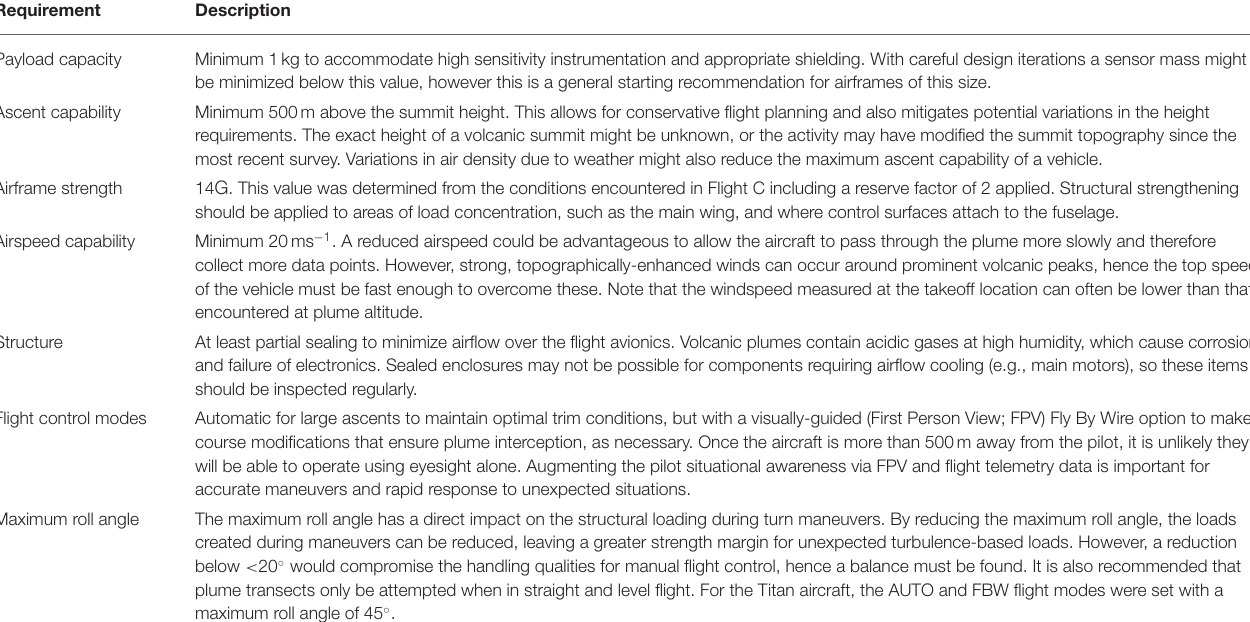
TABLE 4 | Recommended design requirements for fixed-wing UAS, applied to volcanic plume